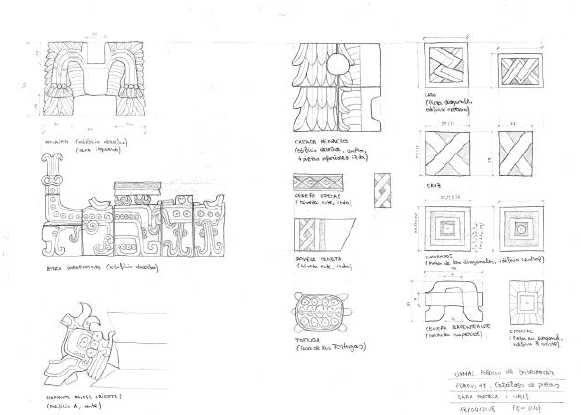
Figure 14. Hand sketch of some carved mosaic-stones of the frieze. (Project MAYATECH 2018).